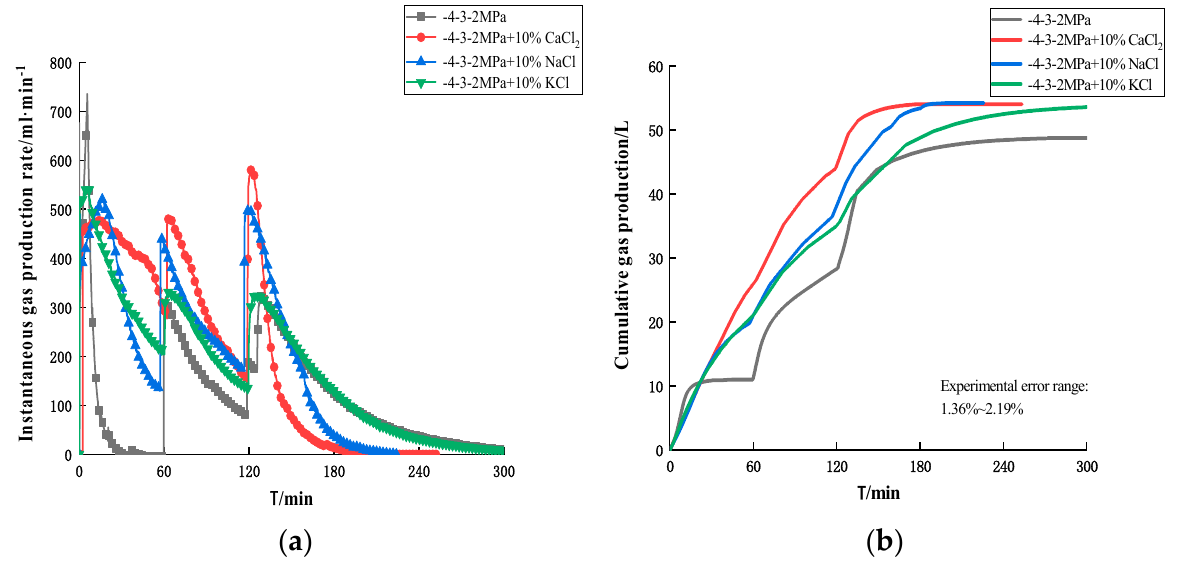
Figure 4. Decomposition curve of multi-stage depressurization and injection of 10% salt hydrate: ( a ) Instantaneous gas production rate; ( b ) Cumulative gas production.